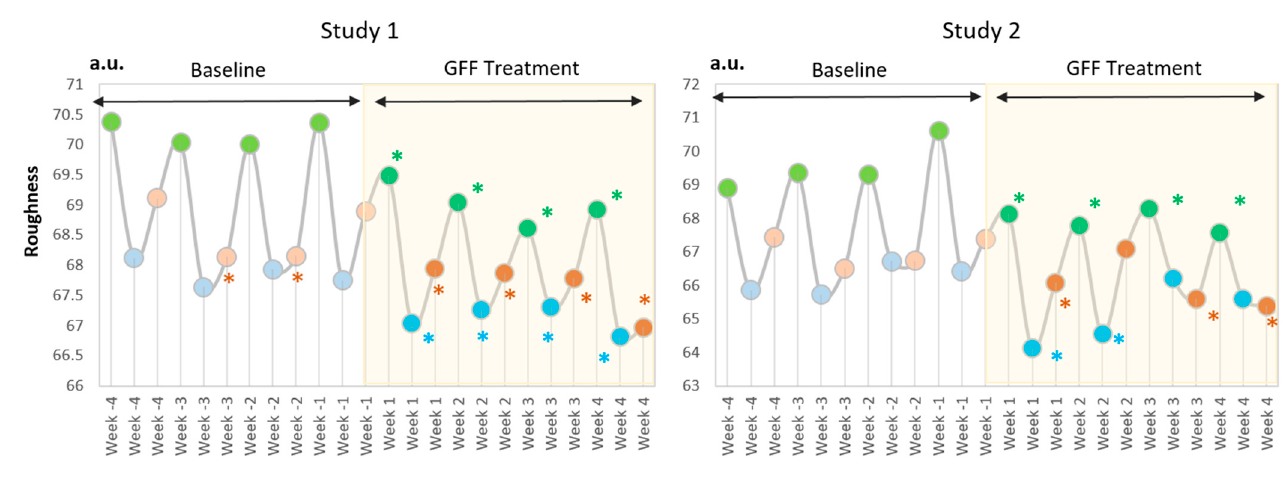
Figure 8. GFF treatment decreases daily fluctuation of roughness. The “Morning after wake ‐ up” ‐ largest fluctuation pat ‐ tern of roughness is demonstrated at baseline period through week ‐ 4 to week ‐ 1. GFF treatment significantly reduces the fluctuation of roughness during week 1 to week 4. *: p < 0.05 compared with “morning after wake ‐ up” at week ‐ 4”. *: p < 0.05 compared with “morning after face wash” at week ‐ 4”. *: p < 0.05 compared with “evening after face wash” at week ‐ 4”.